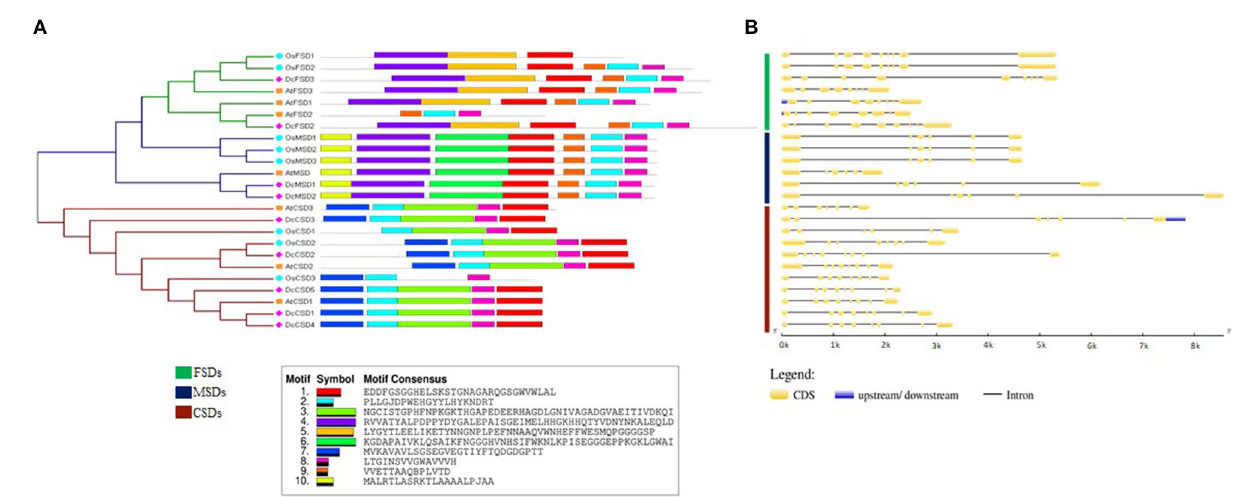
FIGURE 3 | (A) Conserved motif and (B) gene structure analysis of SOD family genes in D. carota .